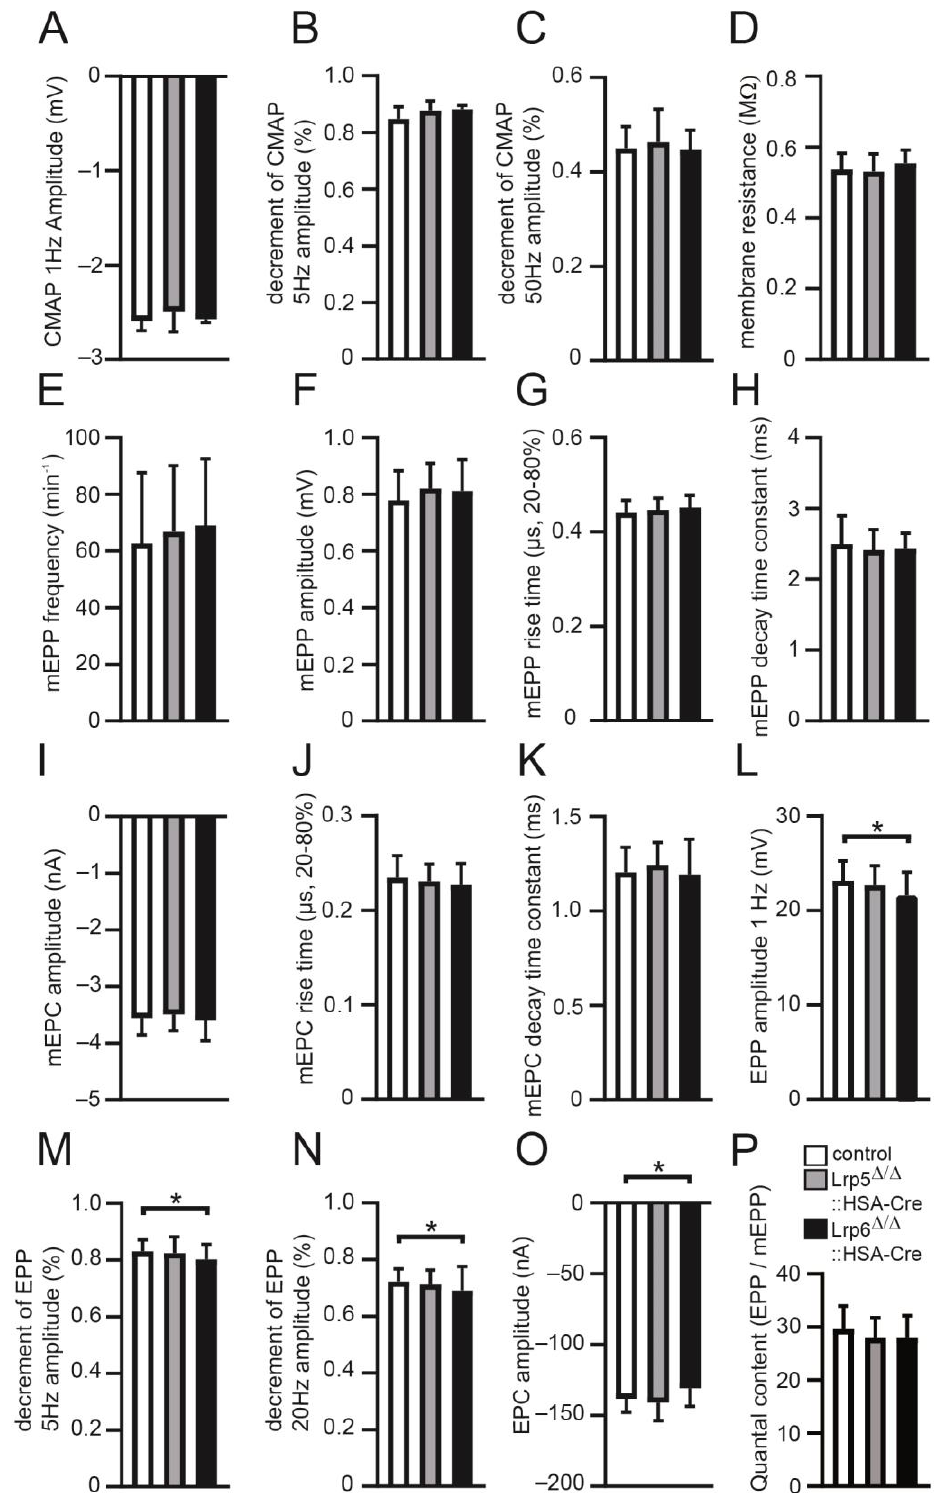
Figure 6. Characterization of neural transmission using conditional Lrp5 or Lrp6 knockout mice. Diaphragms of adult mice of indicated genotypes were used for electrophysiological recordings. Graphs present the analysis of the following parameters: ( A ) compound muscle action potential (CMAP) amplitude at 1 Hz, ( B ) decrement of CMAP amplitude at 5 Hz, ( C ) decrement of CMAP amplitude at 50 Hz, ( D ) membrane resistance, ( E ) miniature endplate potential (mEPP) frequency, ( F ) mEPP amplitude, ( G ) mEPP rise time, ( H ) mEPP decay time constant, ( I ) miniature endplate